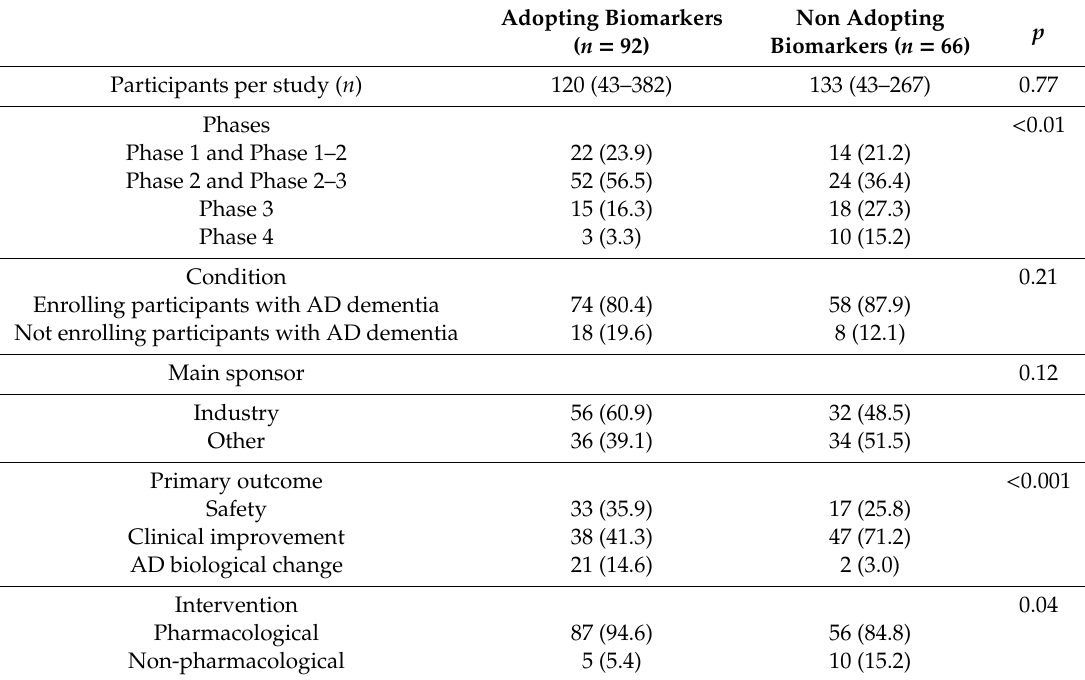
Table 1. Characteristics of the included protocols according to the adoption of